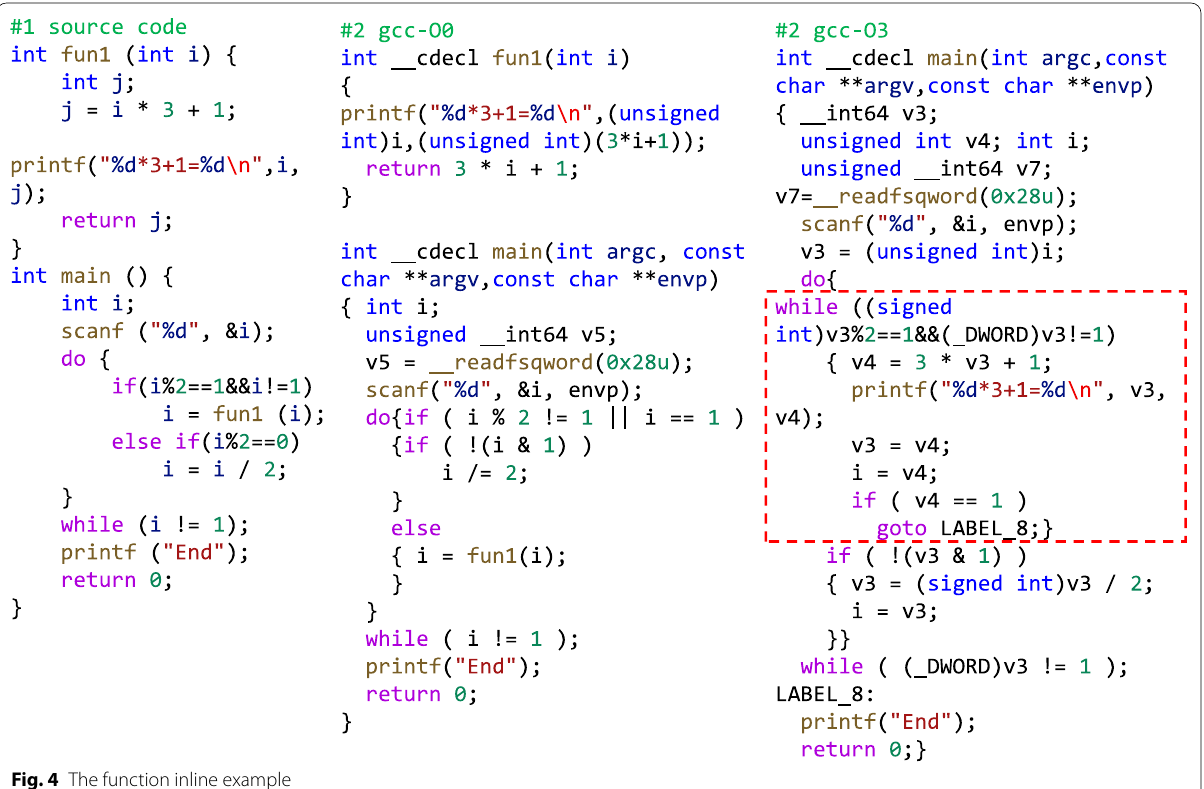
Fig. 4 The function inline